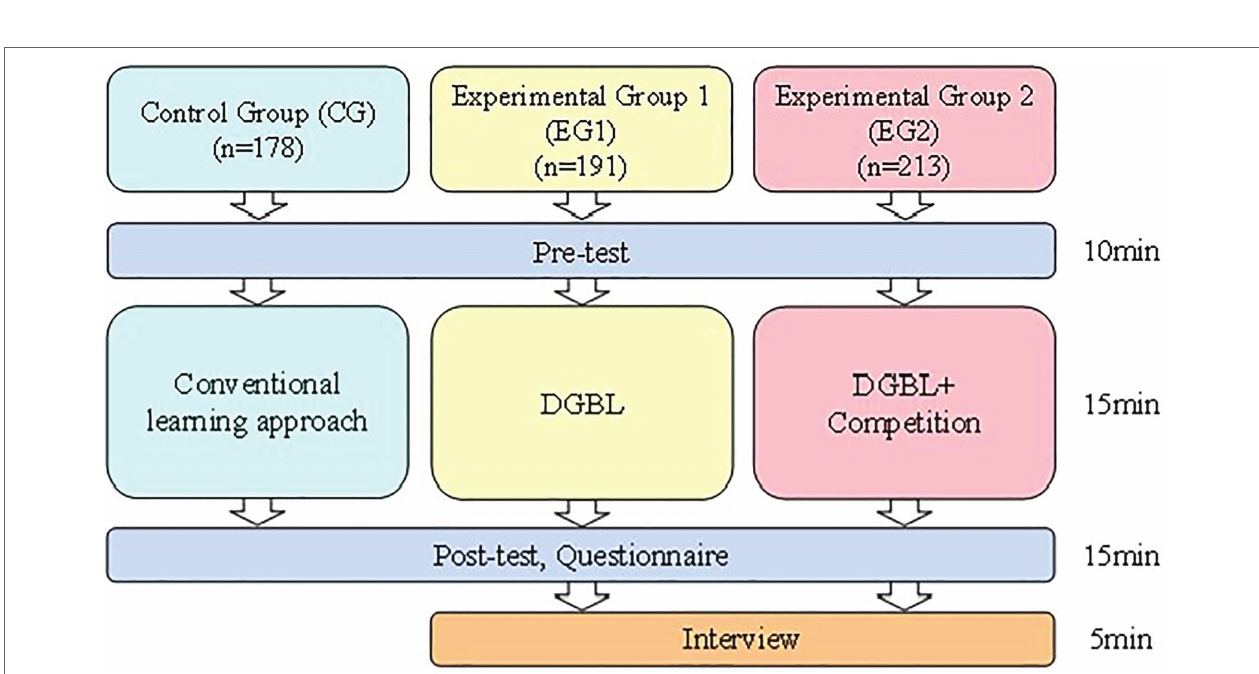
FIGURE 3 | Experiment